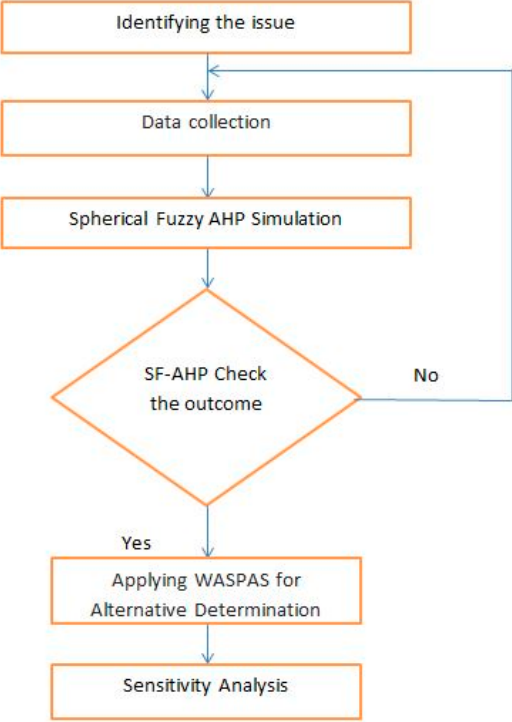
Figure 1. Research